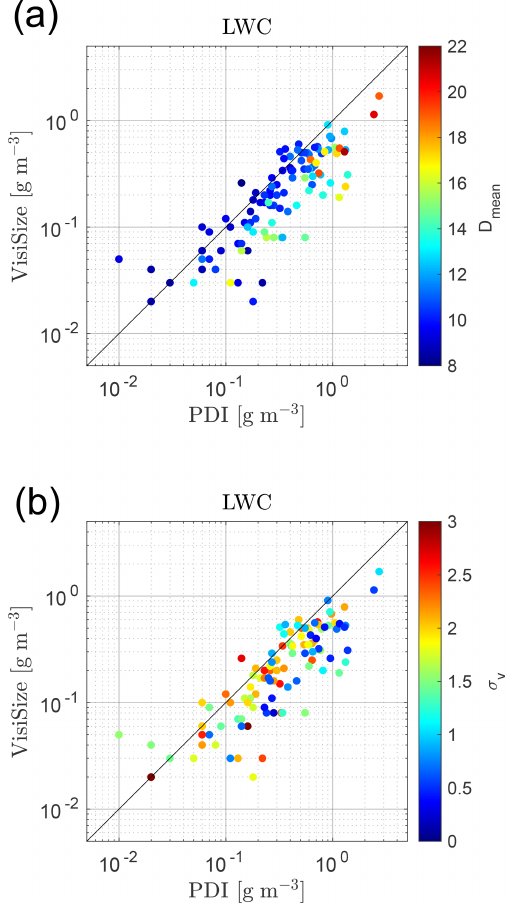
Figure 15. The LWC comparison between the two instruments, while the mean diameter spectra (a) and the standard deviation of velocity spectra (b) are also compared between the selected cases. The results after applying all modifications and filters to the data, and with application of the PVC factor on the modified swept vol- ume method of the PDI, are shown here. The mean diameters and the velocity standard deviations are taken from the VisiSize and the PDI data, respectively. Each circle represents a single measurement of ∼